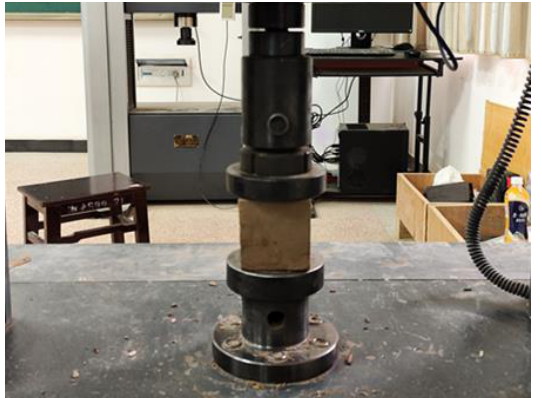
Figure 1. UCS test. Figure 1. UCS test.